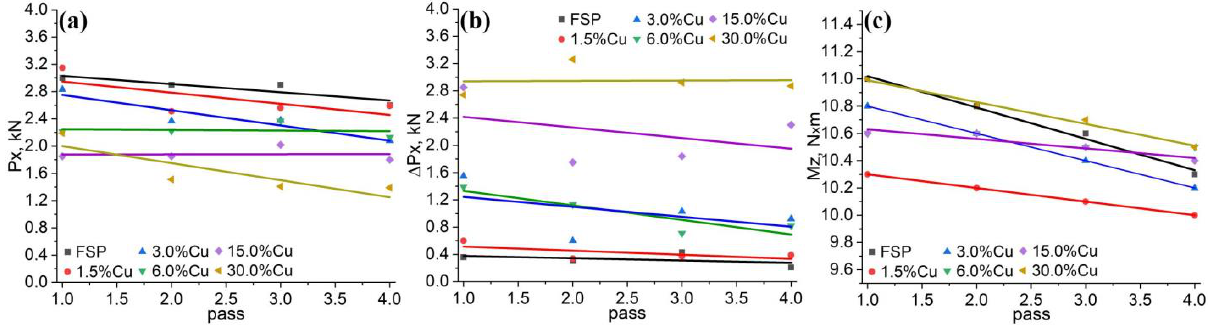
Figure 3. The reaction force ( a ), reaction force scatter ( b ) and torque ( c ) dependencies on the FSP pass number and concentration of copper in samples.